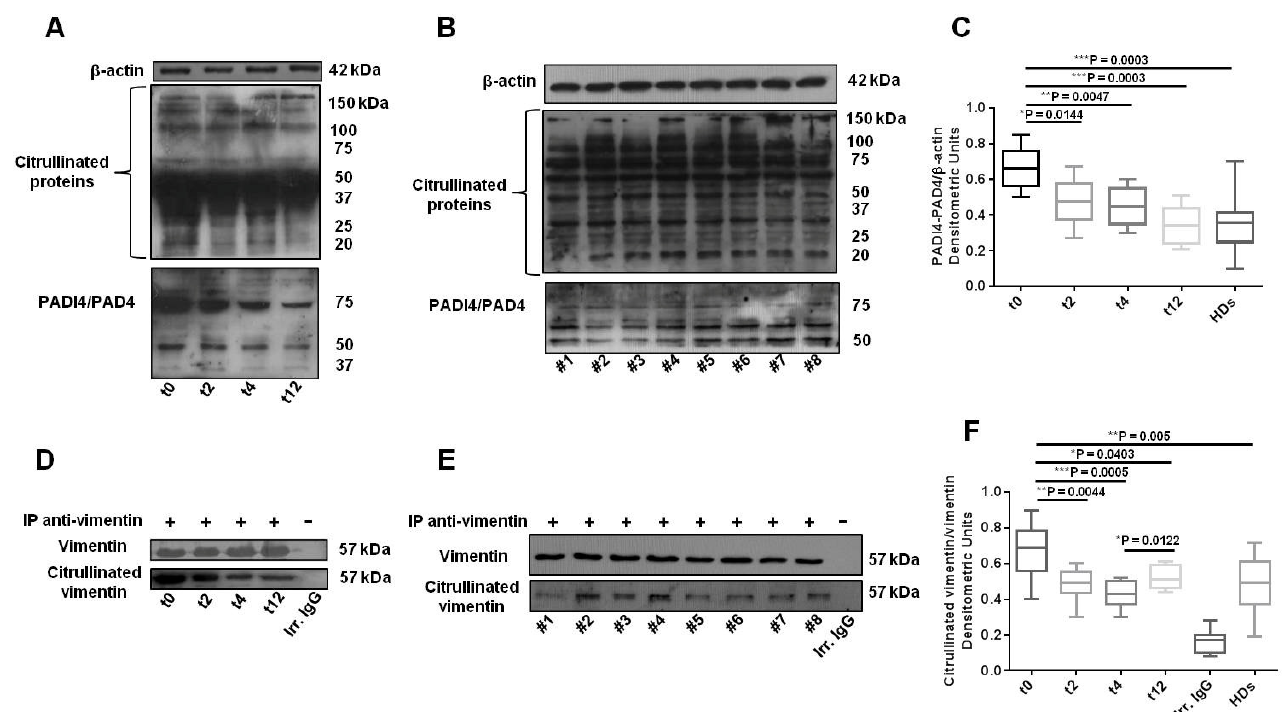
Figure 4. Belimumab decreases protein citrullination in PBMCs from SLE patients. ( A ) Western blot analysis of citrullinated proteins and PADI4/PAD4 enzyme levels in lysates from SLE patients’ PBMCs at baseline (t0) and after 2, 4, and 12 weeks (t2, t4 and t12) of belimumab administration, and ( B ) from healthy donors (HDs). Results from a blot in a representative experiment are shown. ( C ) Densitometric analysis of SLE patients’ and HDs’ PADI4/PAD4 expression levels relative to β -actin, represented as the mean ± standard deviation (SD). In SLE: * p = 0.0144 t0 vs. t2, ** p = 0.0047 t0 vs. t4, *** p = 0.0003 t0 vs. t12. HDs’ PADI4/PAD4 mean expression levels are comparable to those of SLE patients at t12, and lower than those of SLE patients at baseline (*** p = 0.0003 SLE t0 vs. HDs). ( D ) Western blot analysis of citrullinated vimentin immunoprecipitated from SLE patients’ PBMCs lysates at t0, t2, t4, and t12, and ( E ) from HDs. An appropriate IgG isotypic control (irrelevant IgG; Irr. IgG) was employed to verify that immunoprecipitations were correctly performed. Results from a blot in a representative experiment are shown. ( F ) Densitometric analysis of SLE patients’ and HDs’ citrullinated vimentin expression levels, represented as the mean ± standard deviation (SD). In SLE: ** p = 0.0044 t0 vs. t2, *** p = 0.0005 t0 vs. t4, * p = 0.0403 t0 vs. t12, * p = 0.0122 t4 vs. t12). HDs’ citrullinated vimentin mean expression levels are comparable to those of SLE patients at t12, and lower than those of SLE patients at baseline (** p = 0.005 SLE t0 vs.